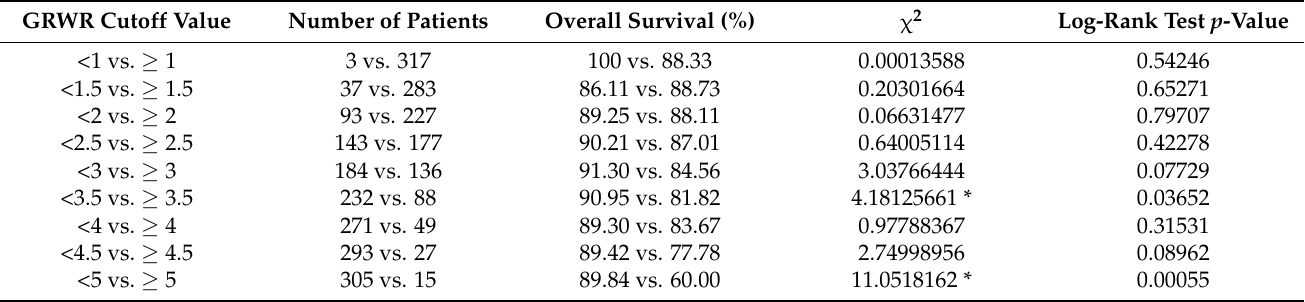
Table 1. Cut-point analysis.